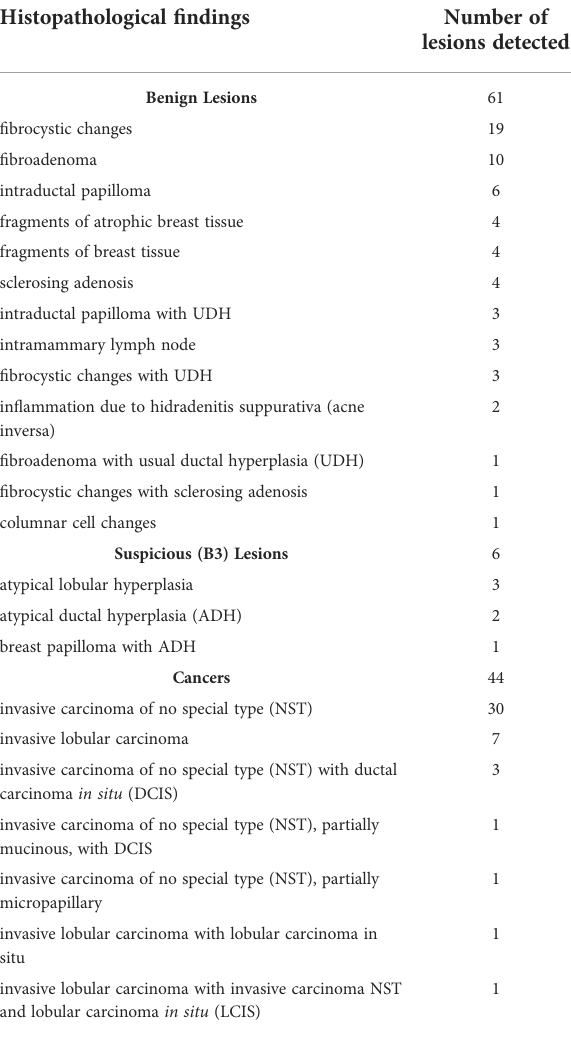
TABLE 1 Distribution of lesions visible in